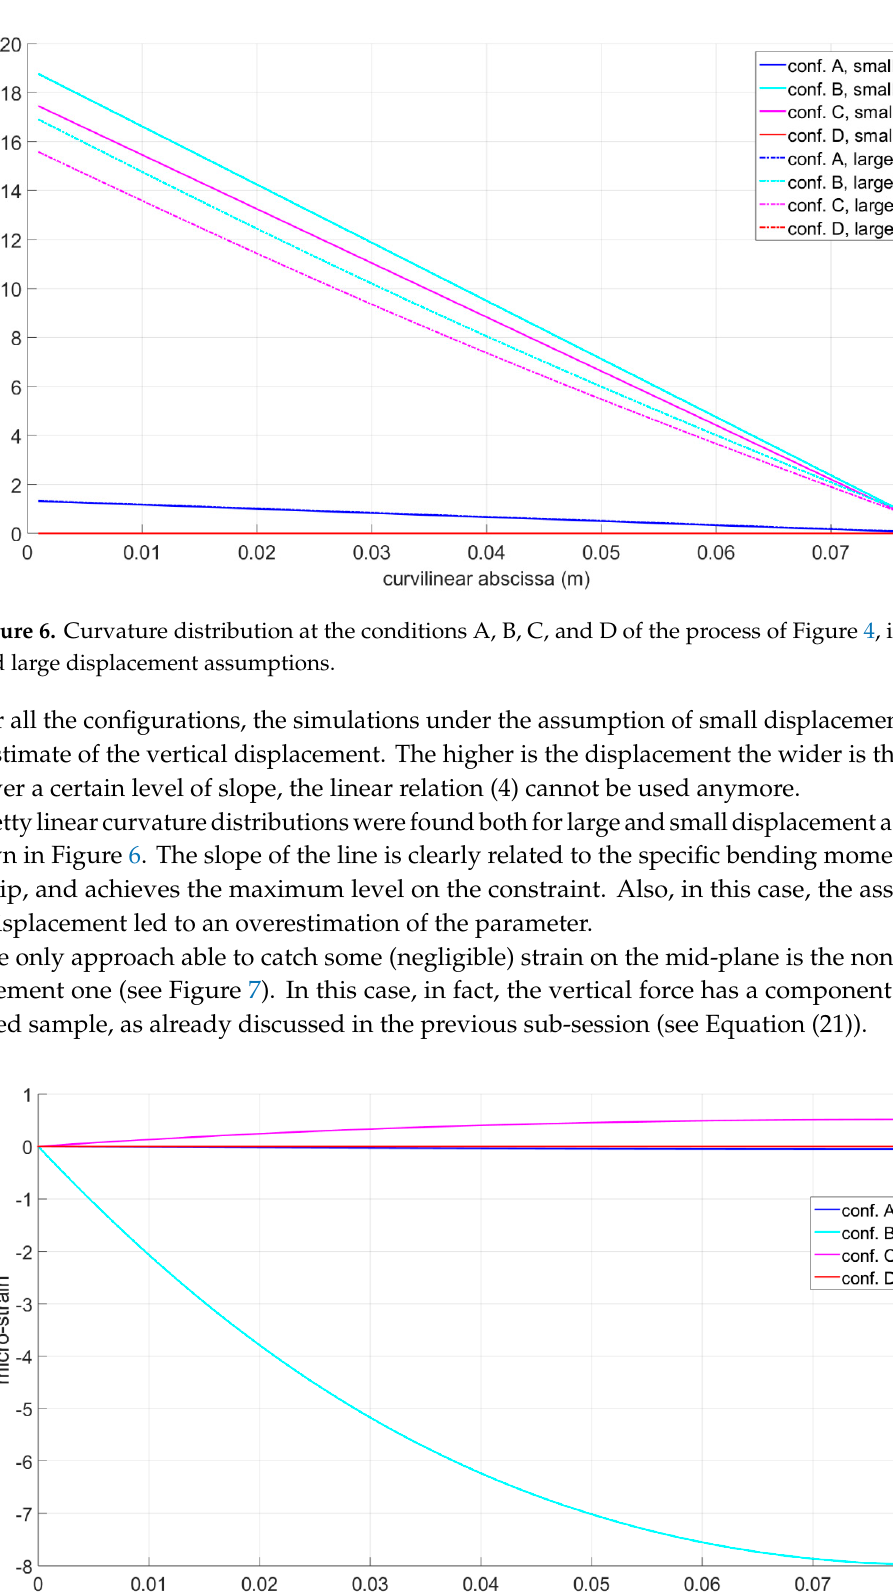
Figure 7. Mid-plane strain at the conditions A, B, C, and D of the process of Figure 4, in large displacement assumption.